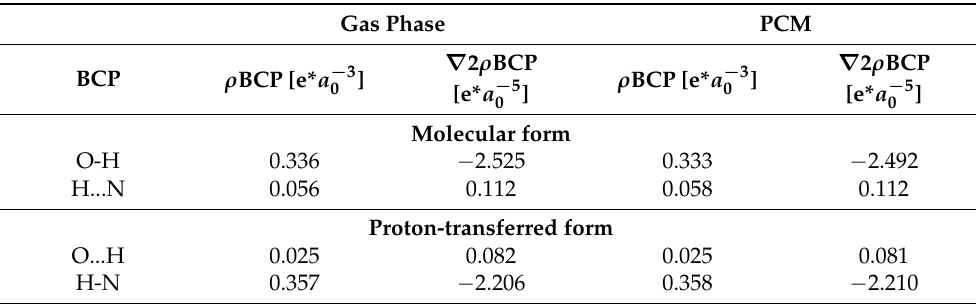
Figure 7. QTAIM topology maps for the para isomer monosubstituted with –NO 2 group in the proximal position 1: ( a ) molecular form in the gas phase, ( b ) proton-transferred form in the gas phase, ( c ) molecular form in PCM, ( d ) proton-transferred form in PCM. The orange and yellow dots mark the BCPs and RCPs, respectively. Yellow lines pinpoint the intramolecular interaction paths. Table 1. QTAIM Bond Critical Point (BCP) properties for selected bonds in the para isomer monosub- stituted with the –NO 2 group in the proximal position